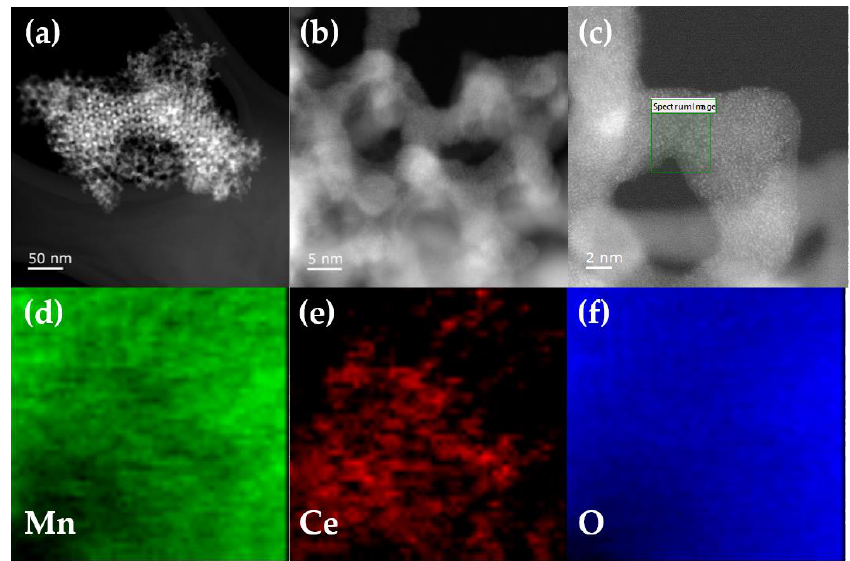
Figure 4. ( a , b ) TEM image of 9MnO 2 – 1CeO 2 . ( c ) EDS elemental mapping of ( d ) Mn, ( e ) Ce, and ( f ) O for 9MnO 2 – 1CeO 2 catalyst.